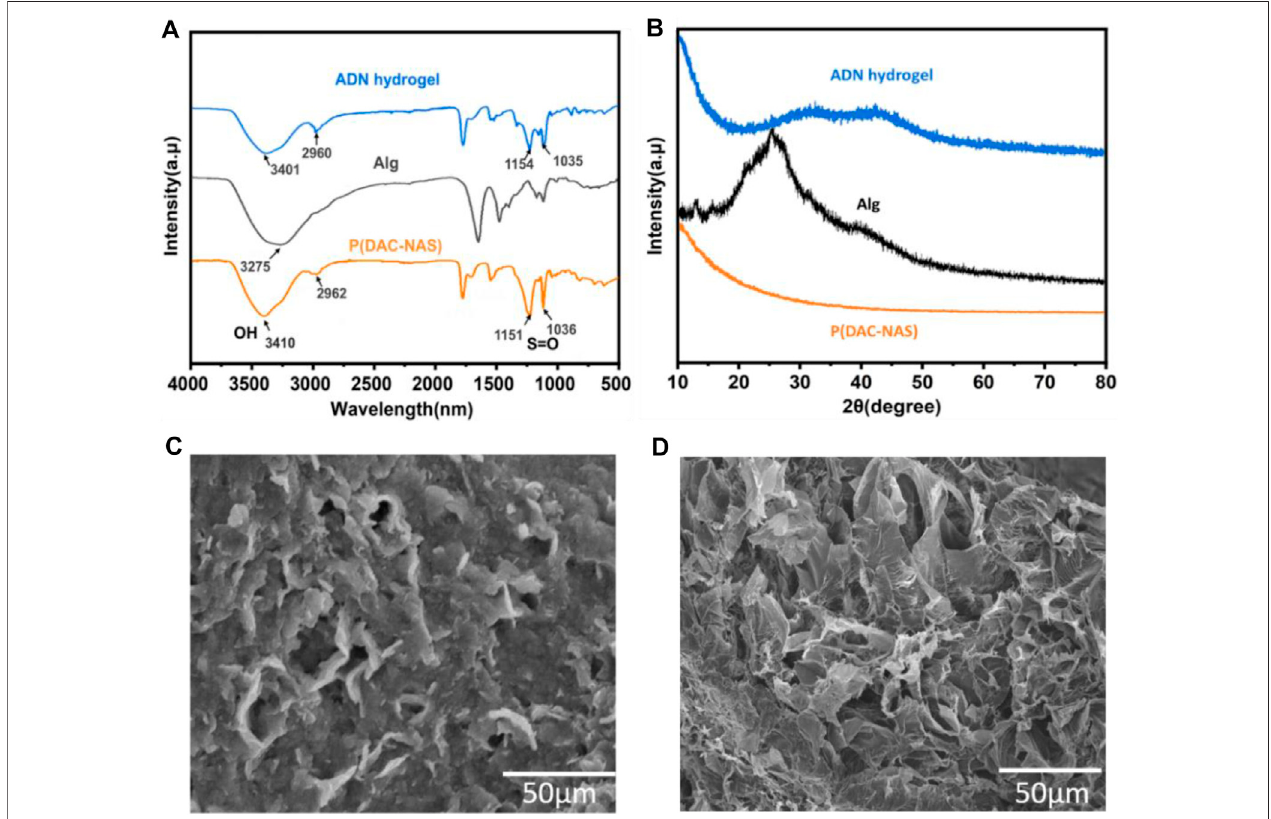
FIGURE 2 | Characterization of the hydrogels. (A) FTIR spectra of Alg, P (DAC-co-NAS) and ADN 1.5 hydrogels. (B) XRD pattern of Alg, P (DAC-co-NAS) and ADN 1.5 hydrogels. SEM images of Alg (C) and ADN 1.5 hydrogels (D)